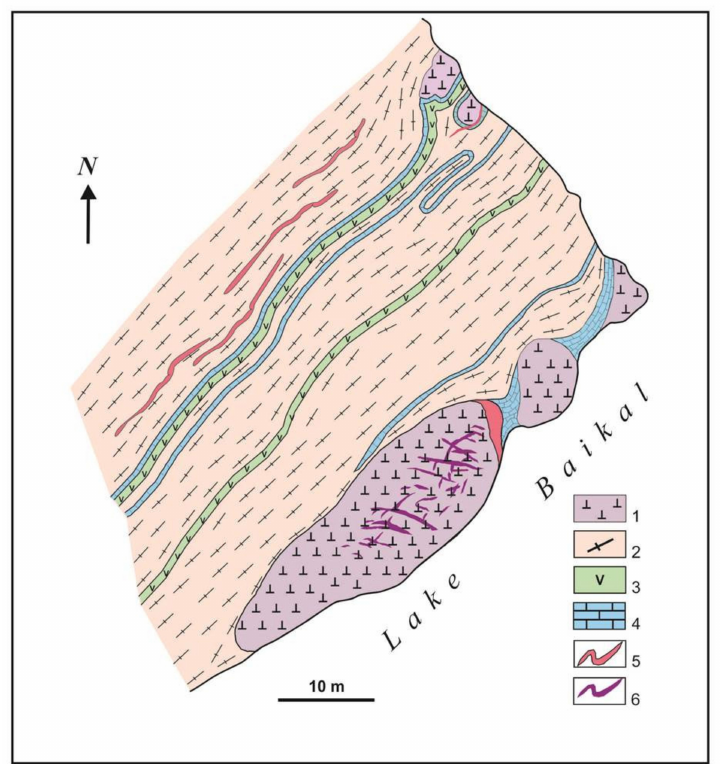
Figure 3. Geological map of Shida Cape, modified after [23]. 1 = dunite; 2 = migmatized biotite–garnet gneiss and blastomylonite; 3 = amphibolite; 4 = calcitic marble; 5 = granite veins; 6 = plagioclasite veins.